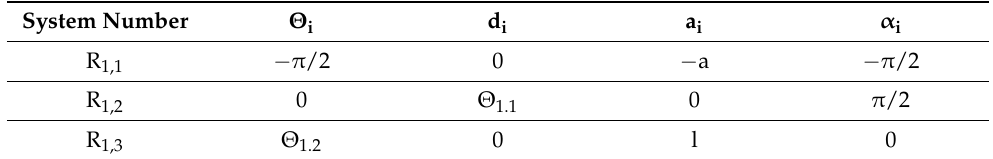
Table 1. The parameters and kinematic variables of a plane manipulator with two degrees of freedom, first arm (upper).